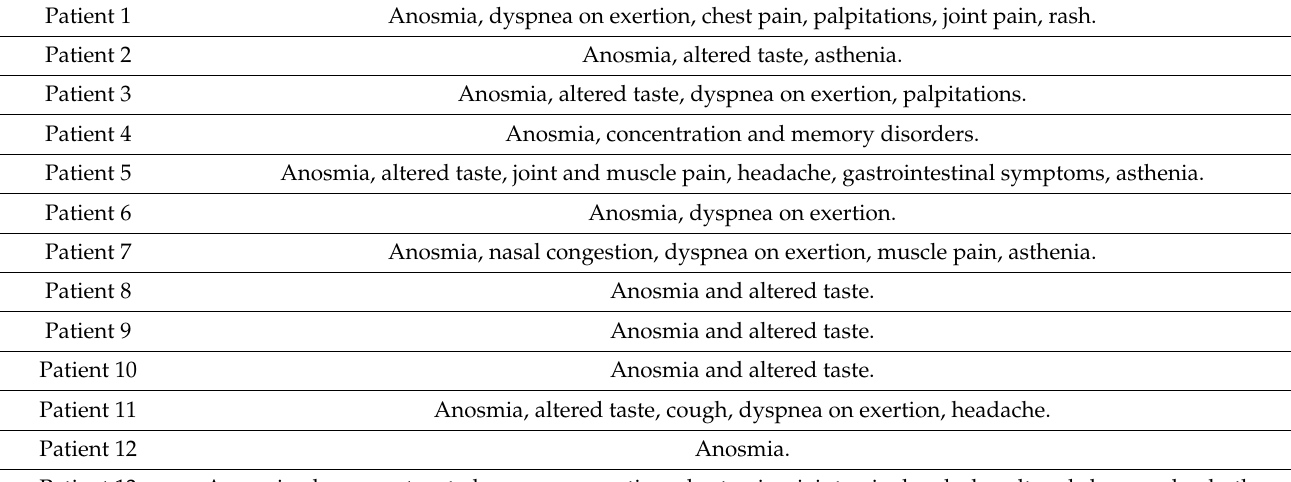
Table 4. Clinical situation of patients suffering from persistent anosmia.